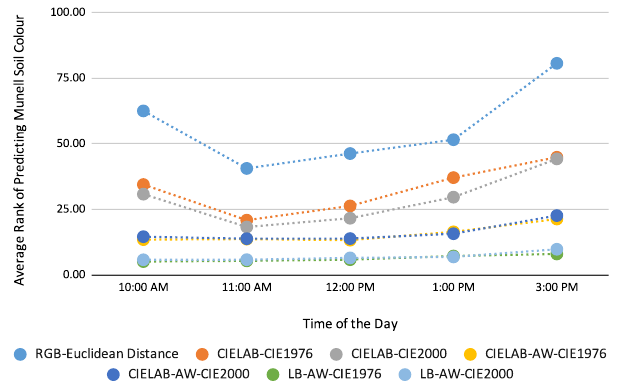
Figure 6. Average prediction rank using Samsung S 10; Colour models used: RGB and CIELAB; Distance Functions employed: Euclidean distance, CIE1976, CIE2000; LB—Australian Location-Based, AW—added weight.